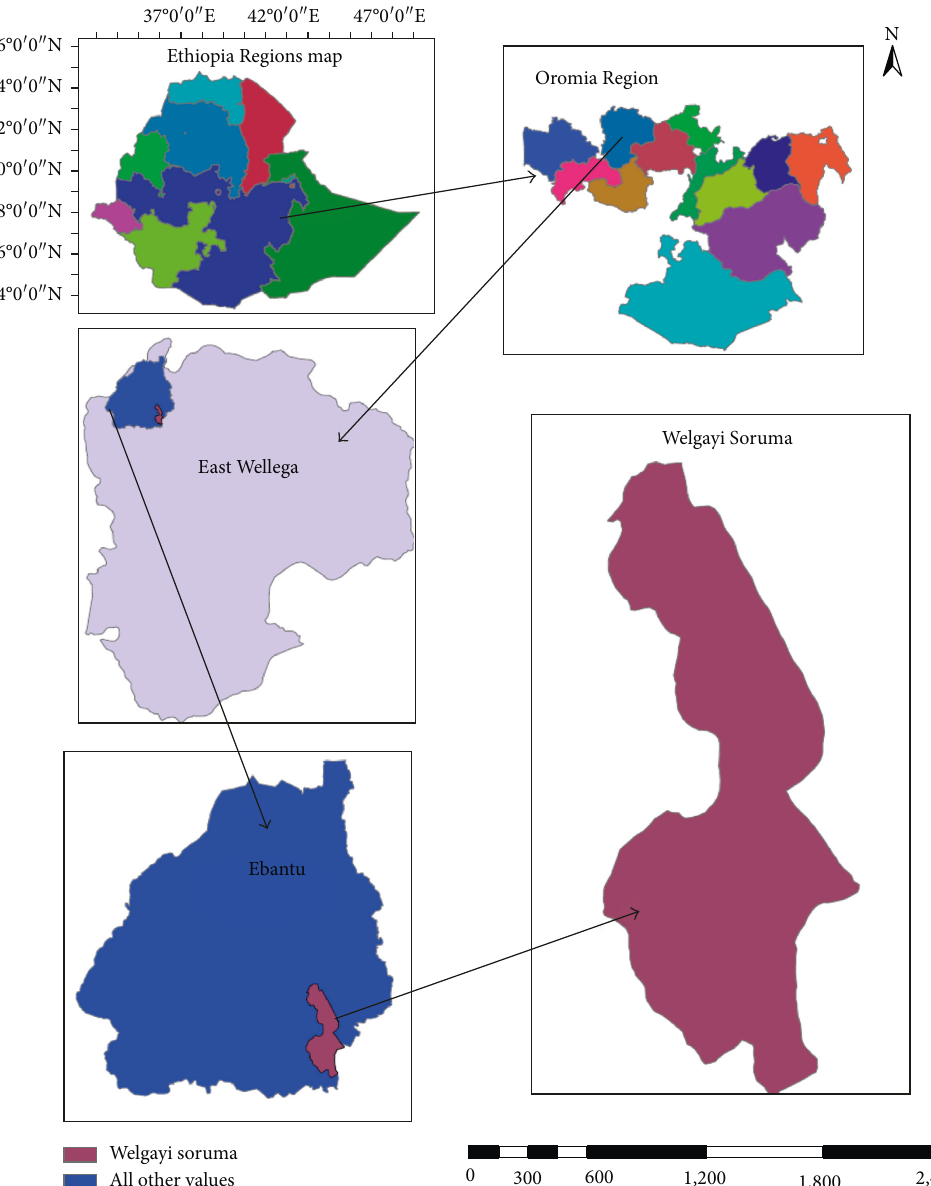
Figure 1: Location map of Ethiopia regions (a) and Oromia National Regional State (ONRS)